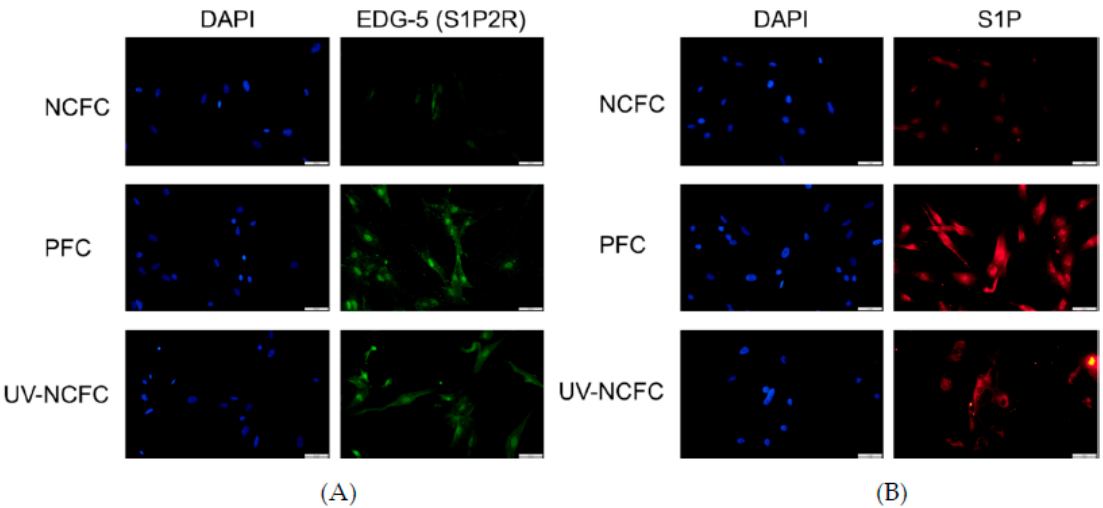
Figure 5. ( A ) Immunocytochemistry of EDG-5 (endothelial differentiation, sphingolipid G-protein-coupled receptor-5) in NCFCs, PFCs, and UV-NCFC. The left panels show cells that were stained with DAPI. The right panels show cells stained for EDG-5. EDG-5 was upregulated in PFCs and UV-NCFCs compared to NCFCs. Bar, 200 µm. ( B ) Immunocytochemistry of S1P in NCFCs, PFCs, and UV-NCFC. The left panels show cells that were stained with DAPI. The right panels show cells stained for S1P. S1P was upregulated in PFCs and UV-NCFCs compared to NCFCs. Bar, 200 µm.